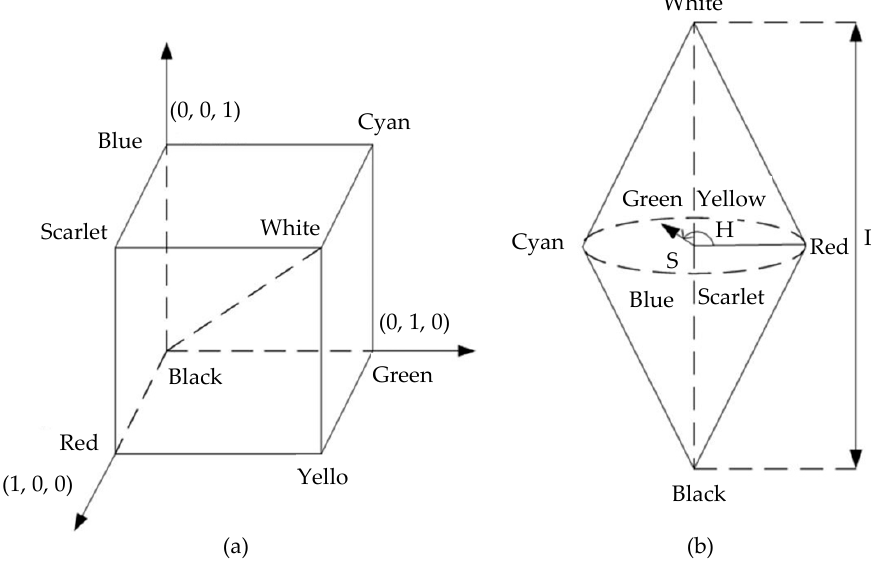
Figure 8. Principle of color conversion algorithm. ( a ) RGB space; ( b ) HSI space.